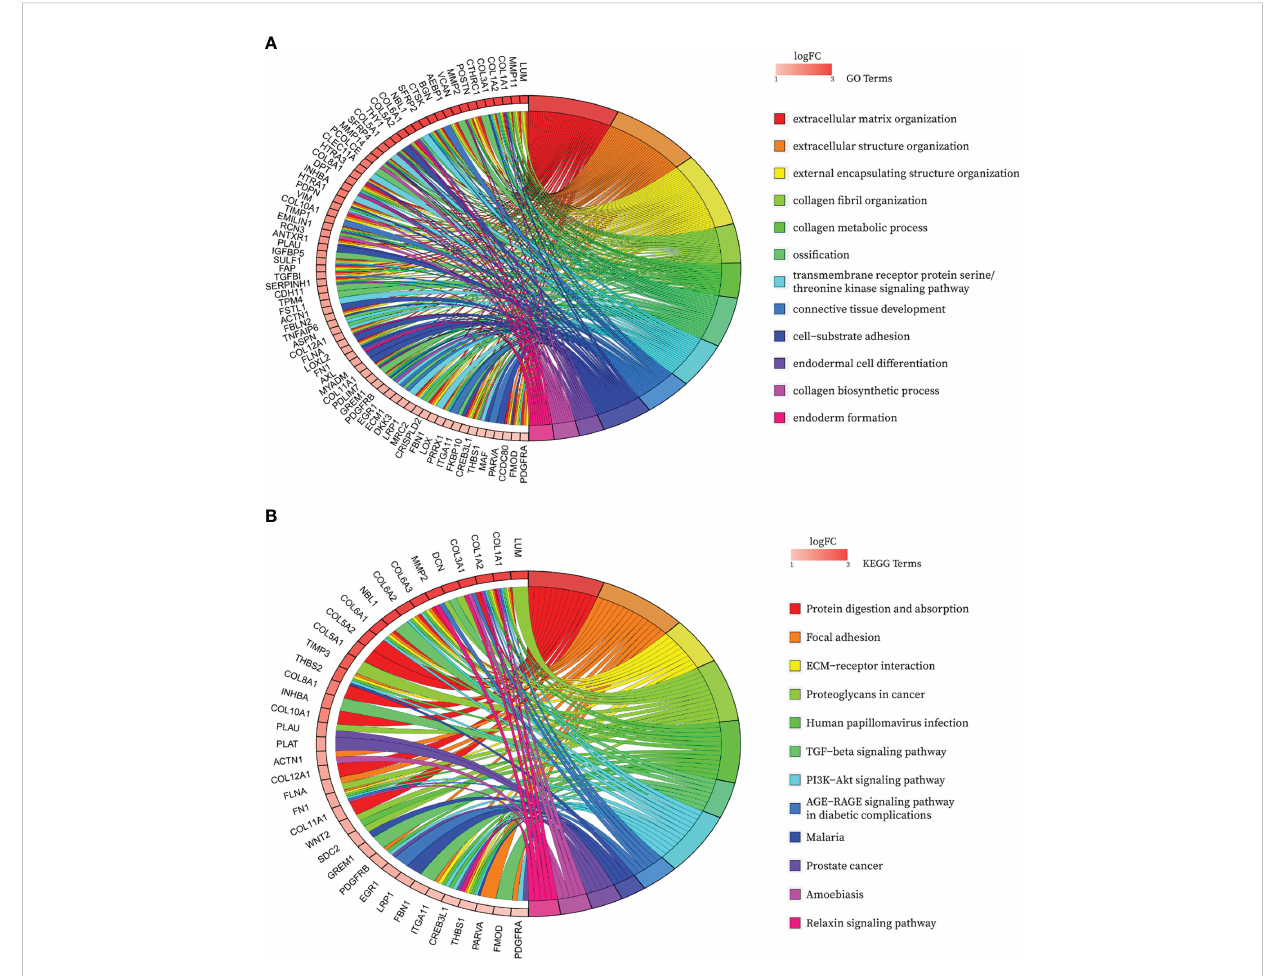
FIGURE 6 Bubble map of functional annotation analyses of 124 CAF marker genes with the (A) GO database and the (B) KEGG